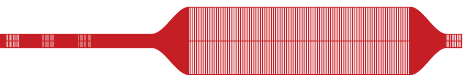
Figure 3: Typical mesh of the compression